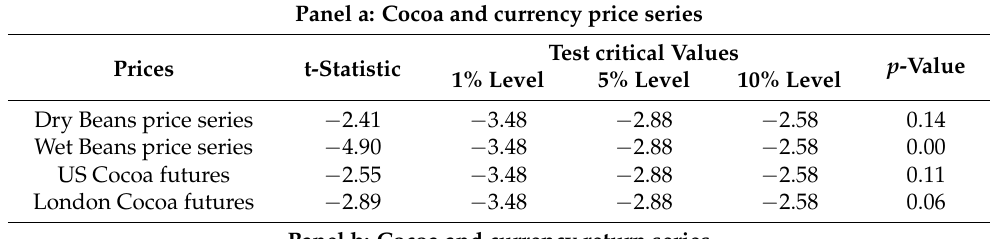
Table 1. Unit-root test results. Source: Authors processing.